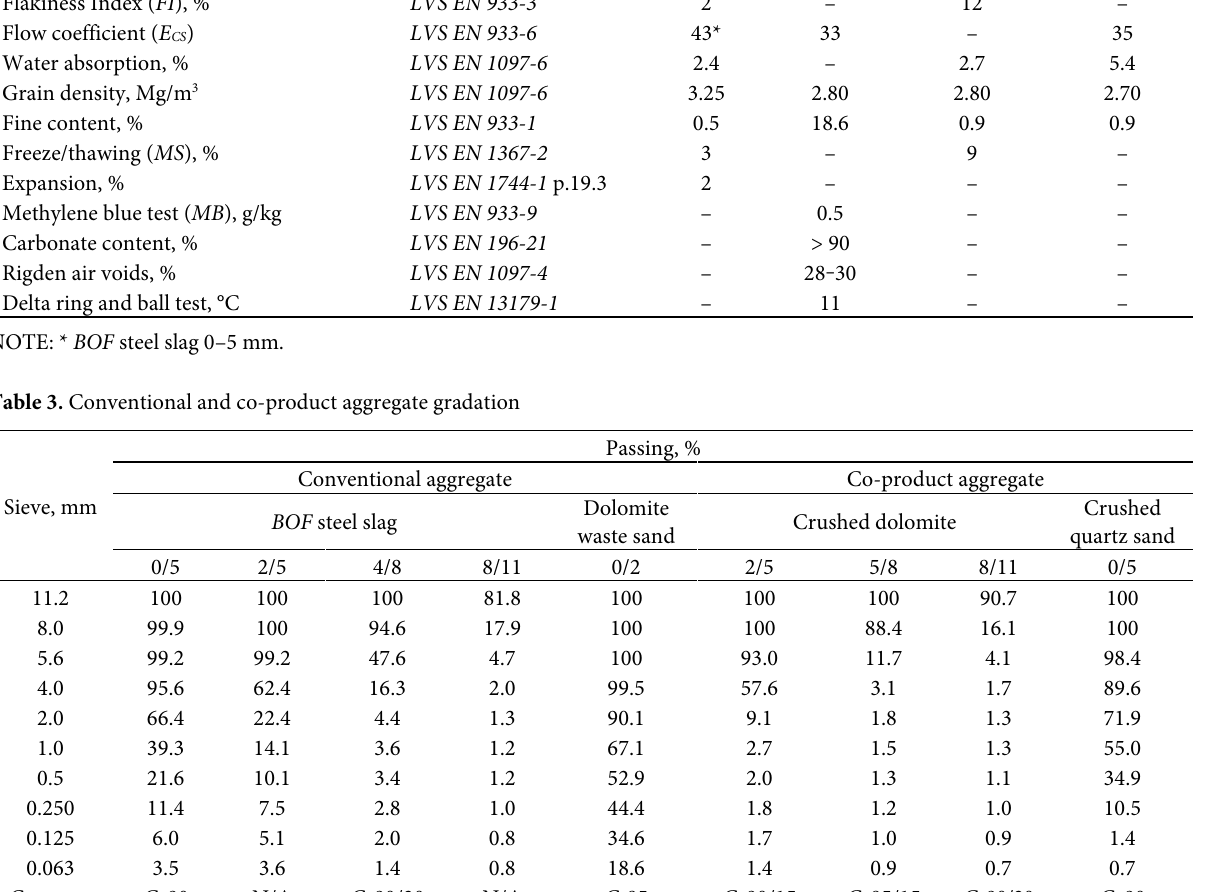
Table 2. Physical and mechanical characteristics of the aggregate Physical and mechanical properties